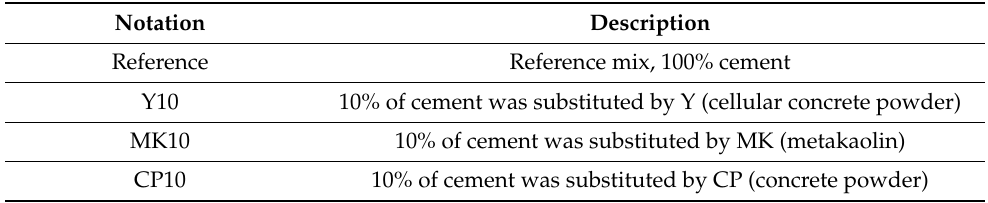
Table 1. Aerated (cellular) concrete (Ytong) powder (Y), concrete powder (CP) and metakaolin (MK) proportions in the mortar samples and the list of laboratory tests